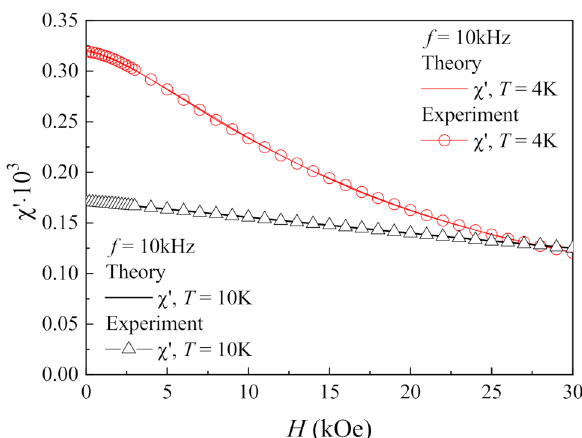
Figure 11. Approximation of the field dependences of the real part of the AC susceptibility of the nanocomposite titanate with the Yb 2 Ti 2 O 7 particles, measured at the frequency f = 10 kHz at the temperatures T = 4 K and 10